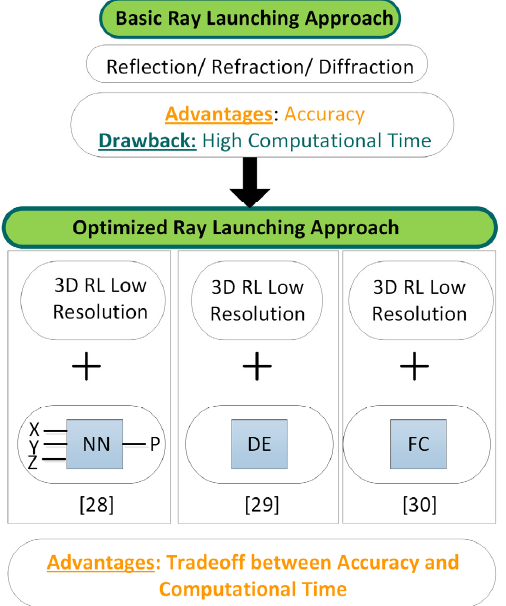
Figure 2. Performance of the in-house 3D ray launching approach.